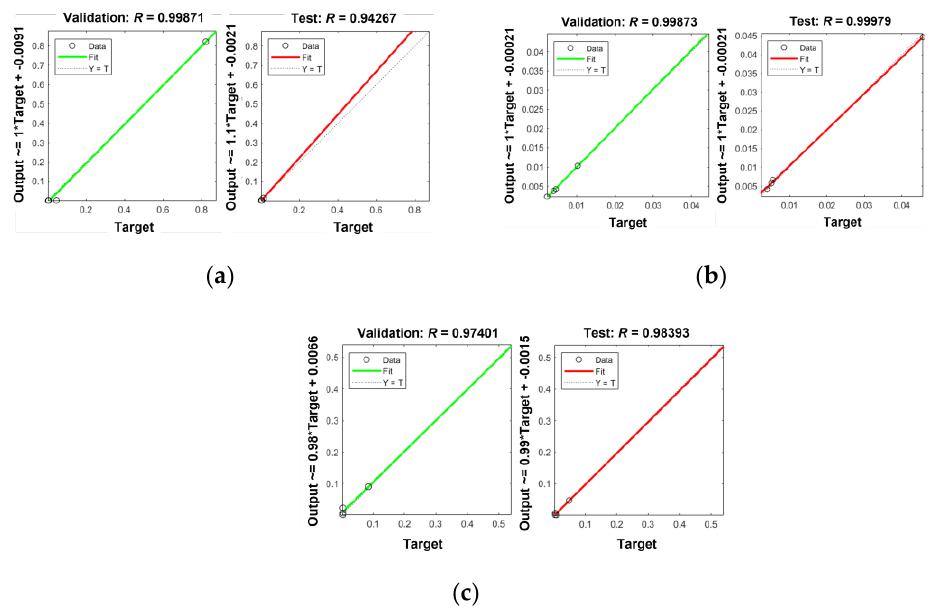
Figure A12. Correlation plots for NN-PSO simulations of TCR (children) for ( a ) TW, ( b ) GW, and ( c ) WRS.